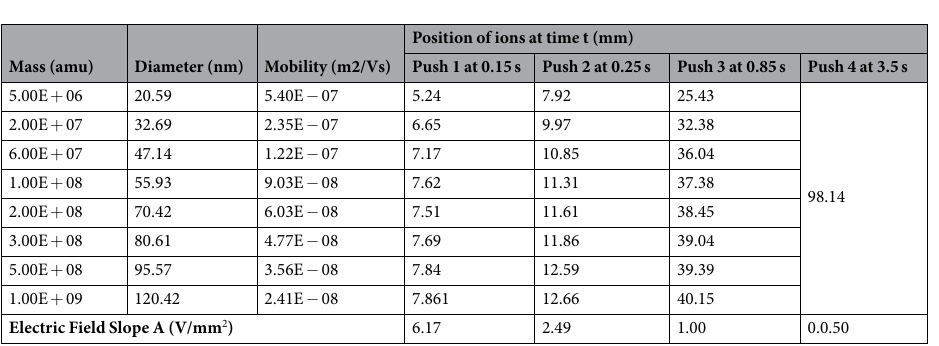
Table 1. Parameters used for the SIMION simulation for IPF. The average position of every type of ion is shown at the beginning of every push in